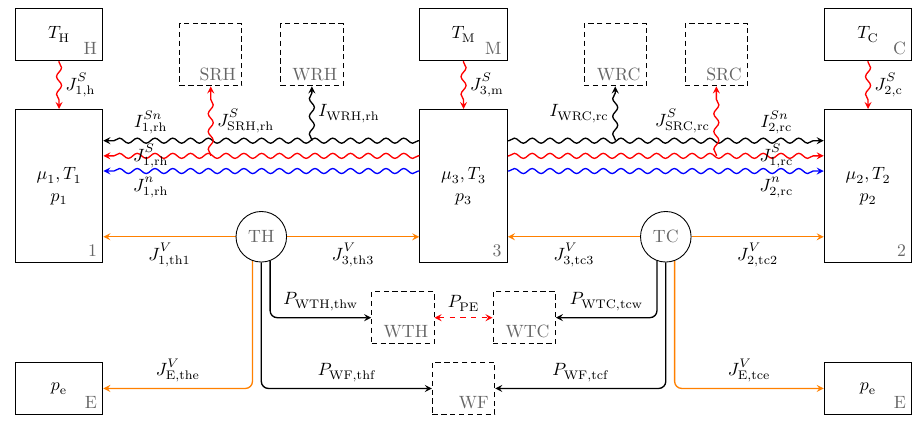
Figure 2. Endoreversible setup of the Vuilleumier refrigerator considered here. The external heat sources/sinks are modeled by the three reservoirs ( T H , T M , T C ). These are closely coupled by heat exchangers to the corresponding inner working spaces modeled as reservoirs with temperatures ( T 1 , T 2 , T 3 ). The two engines TH and TC provide the mechanical power to compensate the frictional forces on the hot and cold side, respectively. Note the power exchange P PE between the bookkeeping reservoirs WTH and WTC for the mechanical power, which is only present in the D1 and D2 design discussed